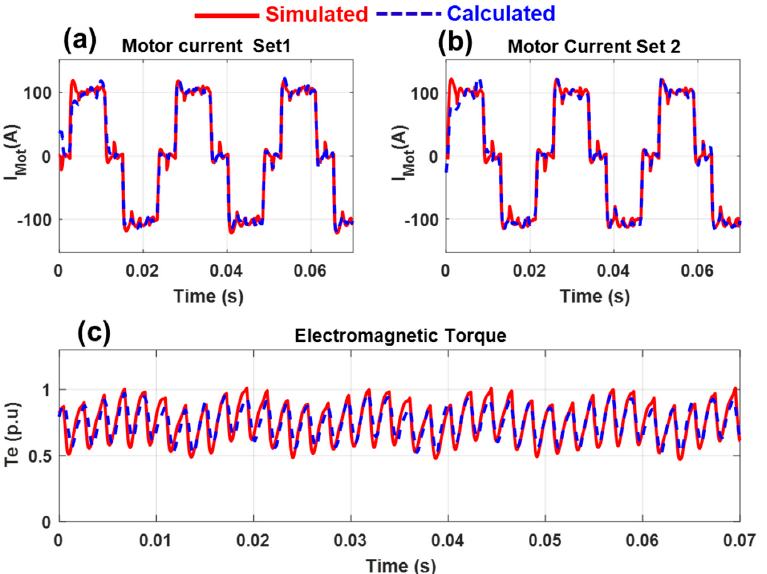
Figure 24. Reconstructed instantaneous electromagnetic torque waveform for a 12/12-pulse LCI system at 40 Hz: ( a ) reconstructed waveform of motor current set 1, ( b ) reconstructed waveform of motor current set 2, and ( c ) reconstructed torque waveform.